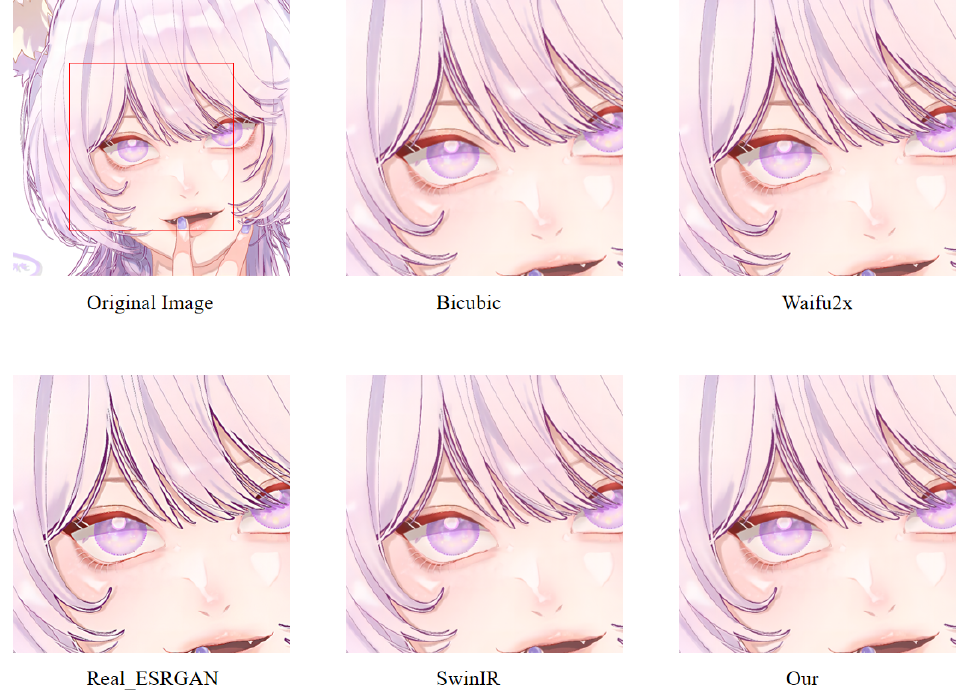
Figure 22. A result of an example image from the Animeface180 test dataset for different super- resolution methods. Facial detail comparison at 2 × super-resolution